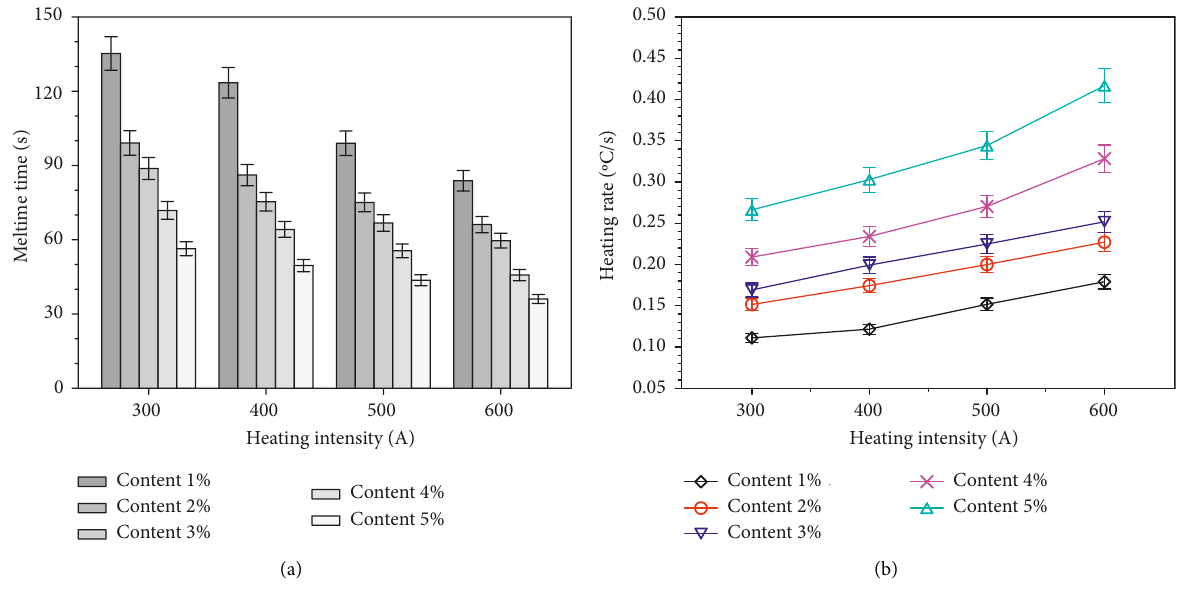
Figure 9: Ice-melting performance under different heating intensities.